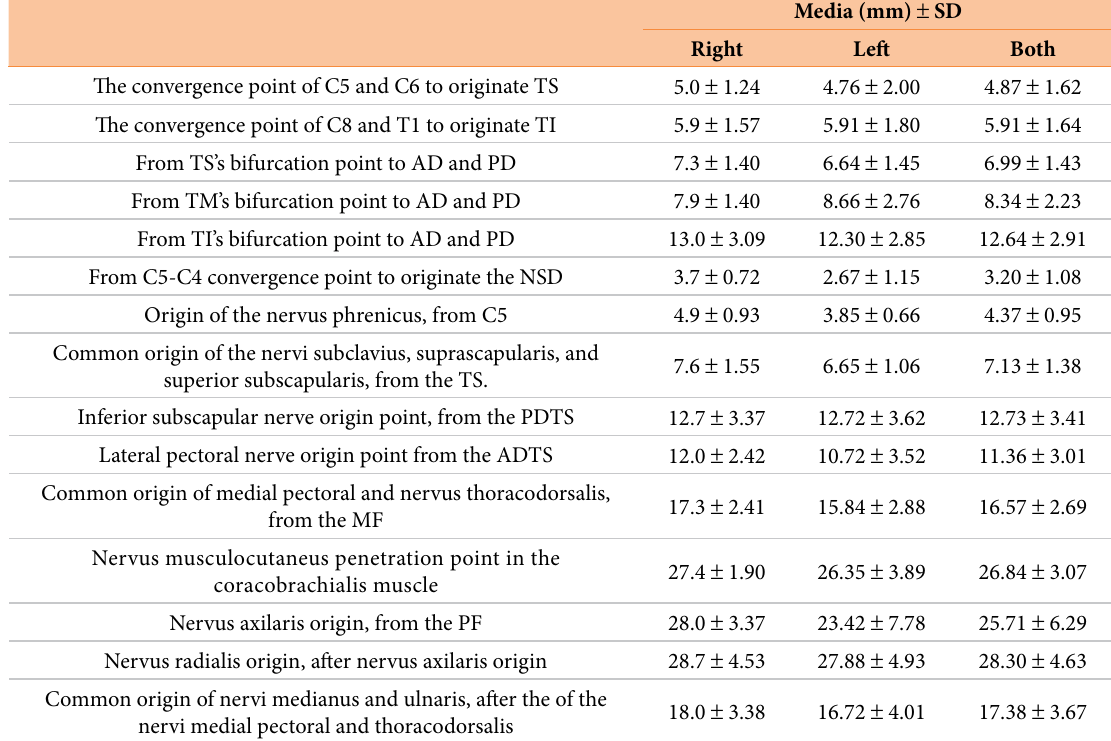
Media (mm) ± SD Right Left Both